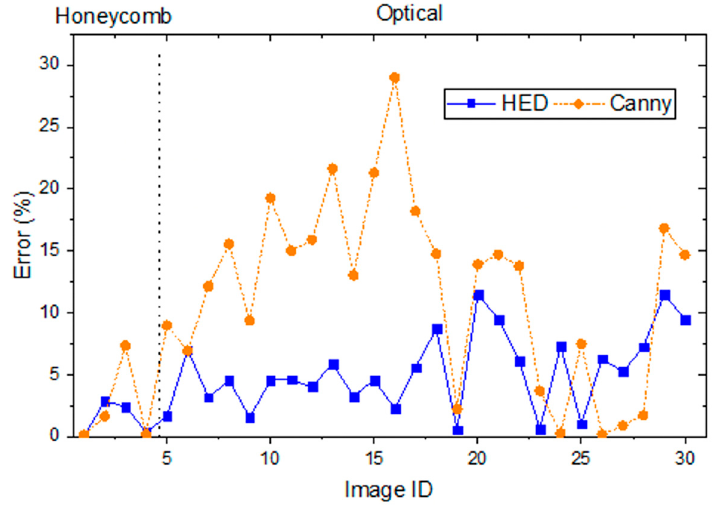
Figure 4. Grain size measured by HED and Canny edge detection algorithms compared to line intercept method reported as % error.